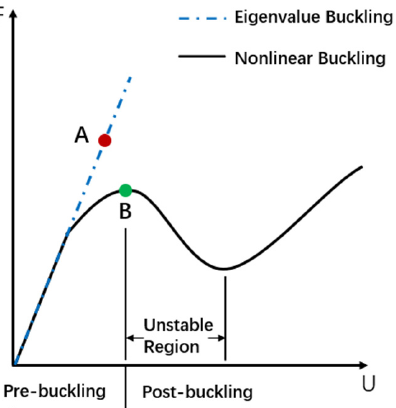
Figure 10. Buckling analysis curve. A is the linear eigenvalue buckling value, B is the nonlinear buckling value.